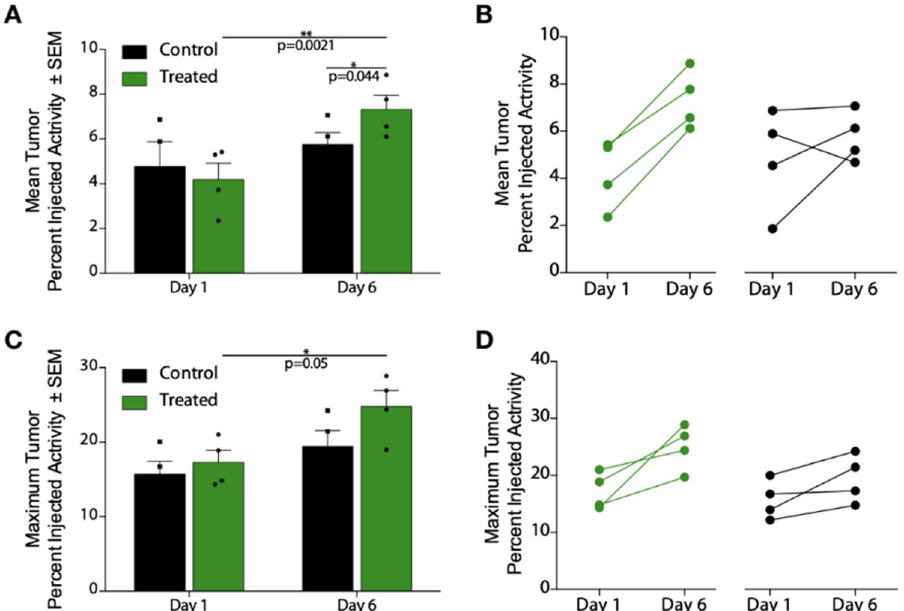
Figure 4. [ 18 F]-PARPZ Uptake and Response Data: Noninvasive PET imaging analysis was used to measure [ 18 F]-PARPZ uptake in treated and control groups. ( A ) Mean percent injected activity per gram (%IA/g) in the tumors did not significantly vary at the early imaging time point. After 6 days of [ 225 Ac]-PSMA-617 decay, the mean %IA/g significantly increased in the treated group ( P < 0.05). The two groups can be distinguished at this later time point by the mean uptake values ( P < 0.005). ( B ) Before-after plot of the individual changes in replicates’ mean uptake values. ( C ) Maximum tumor voxel %IA/g is plotted, showing an increase for the treated animals between Day 1 and Day 3 ( P < 0.05). A trend for increased maximum [ 18 F]-PARPZ is present between the control and treated groups at Day 6, but is not significant. ( D ) Changes in individual replicates’ maximum %IA/g.